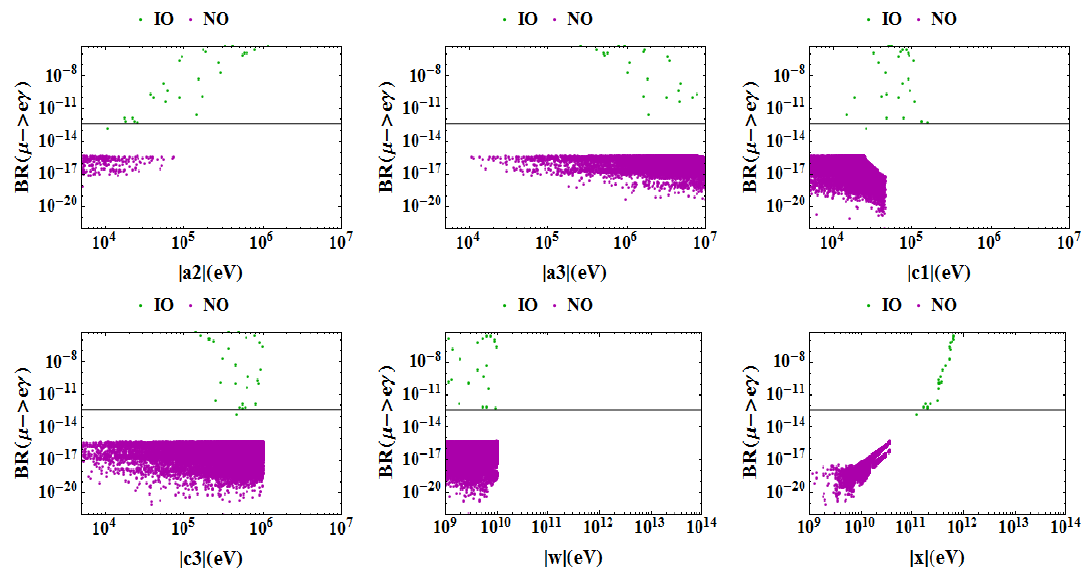
Figure 28 . BR for (cid:22) ! e (cid:13) as a function of model parameters for the class B3. The horizontal line represents the upper limit for BR given by MEG experiment. Figure 29 . BR for (cid:22) ! e (cid:13) as a function of model parameters for the class B4. The horizontal line represents the upper limit for BR given by MEG experiment. { 33